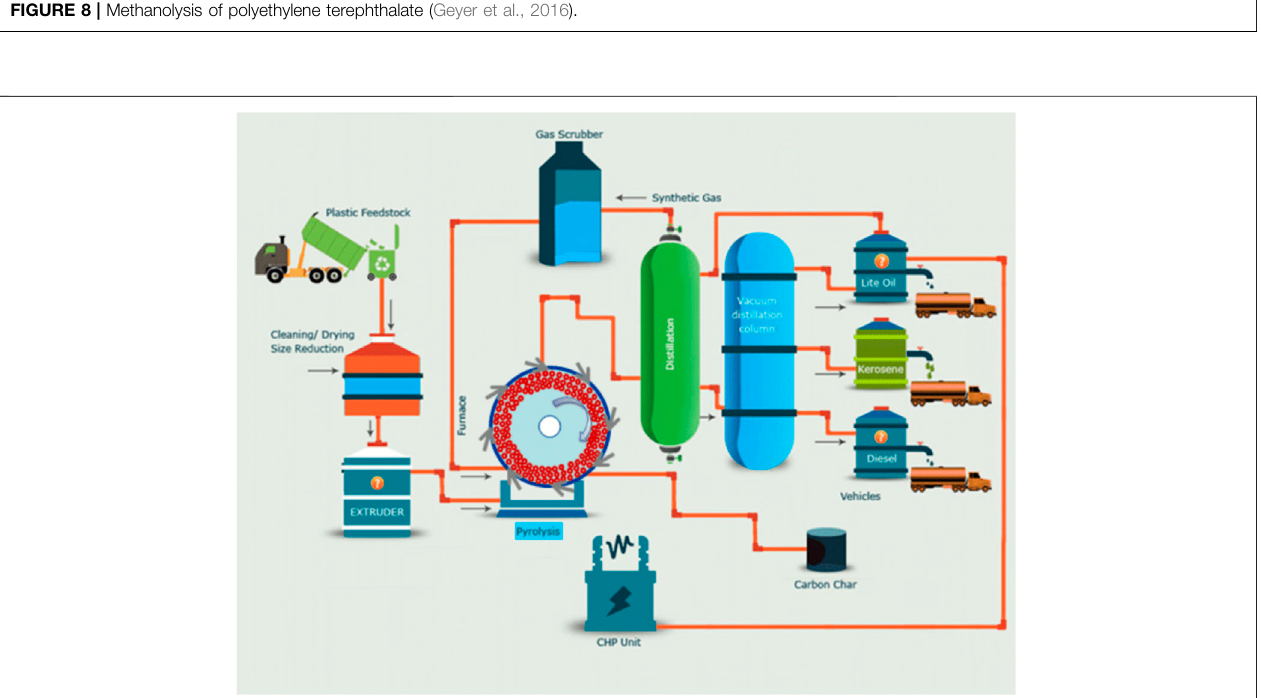
FIGURE 9 | A typical pyrolytic process for plastic waste management (Ragaert et al., 2017).